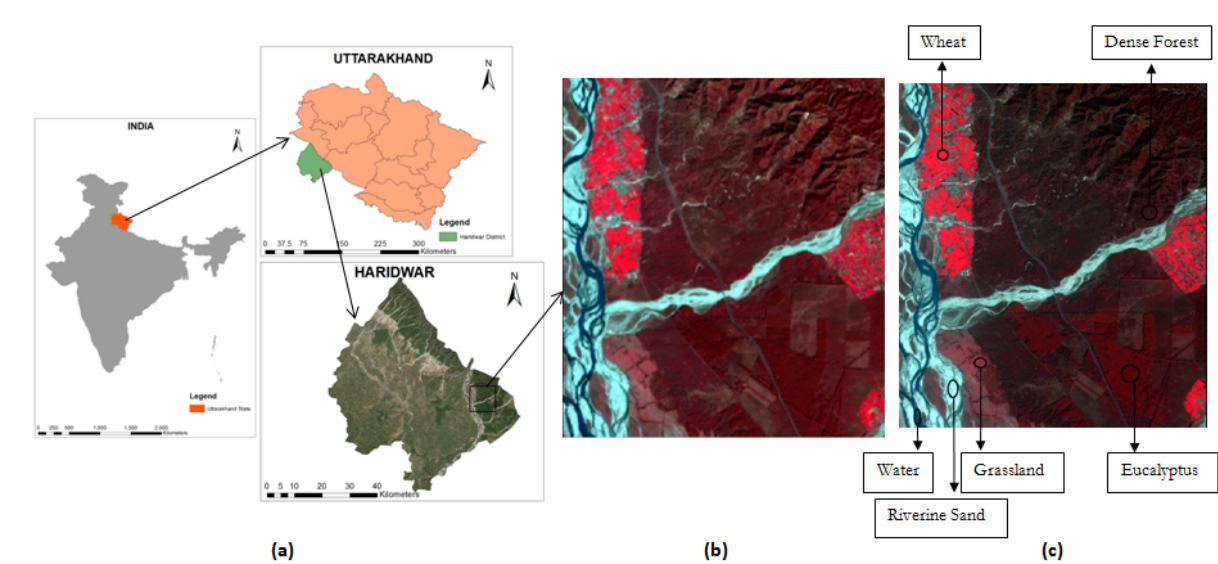
Figure 1. ( a ) The study area, located in the Haridwar district of Indian state Uttarakhand. ( b ) False-color composite of Landsat-8 image of the study area. ( c ) False-color composite of Formosat-2 images with the identified LULC classes in the study area.